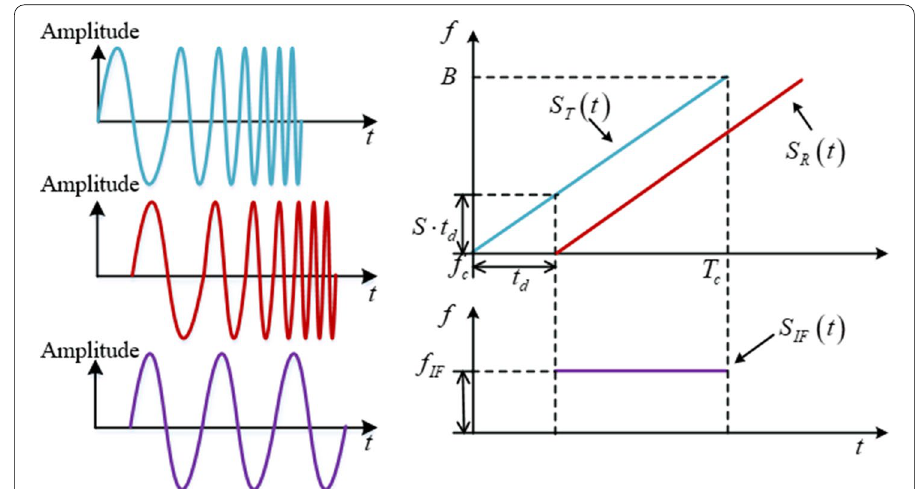
Fig. 2 The schematic diagram of the radar